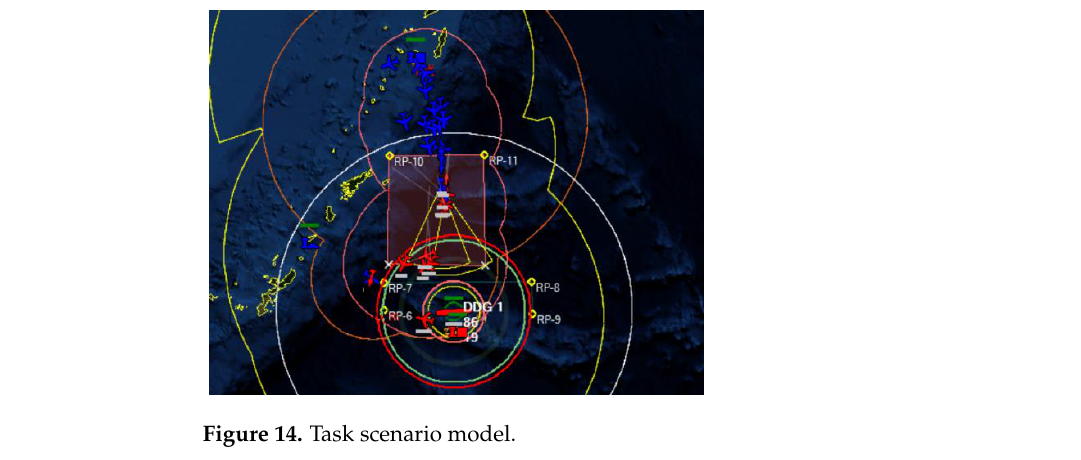
19 of 22 Figure 13. Comparison of efficiency of different algorithms. 5.2. Simulation Experiment How to select the flight unit and mount for the task execution sequence before the task execution is a difficult decision-making point. The Avionics Cloud system can call the DiMining algorithm to analyze the past dataset to output an efficient task execution sequence pattern to assist in decision making after the target demand is known. As shown in Figure 14, the specific simulation scenario is as follows: UAV formation in a sea 10,000 square nautical miles within the sea stereo detection task, detection target for another UAV formation, and the experimental data were collected using a simulation scenario software named Origin, developed by Shareetech. In Figure 14, the blue side represents our reconnaissance aircraft and the red side represents the target to be detected. The effi- ciency is judged by the number of detected target clusters under the specified time, and